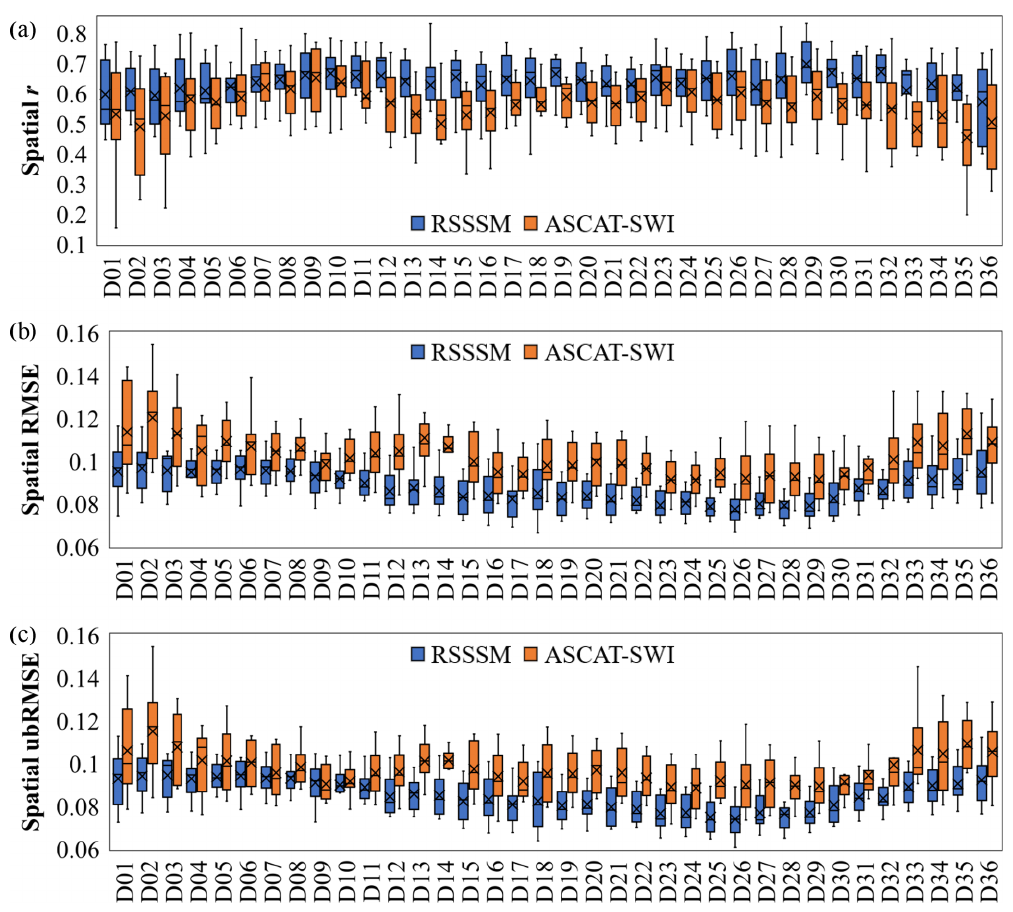
Figure 9. Comparison of the spatial accuracy between RSSSM and ASCAT-SWI during different 10d periods. The evaluation indexes are